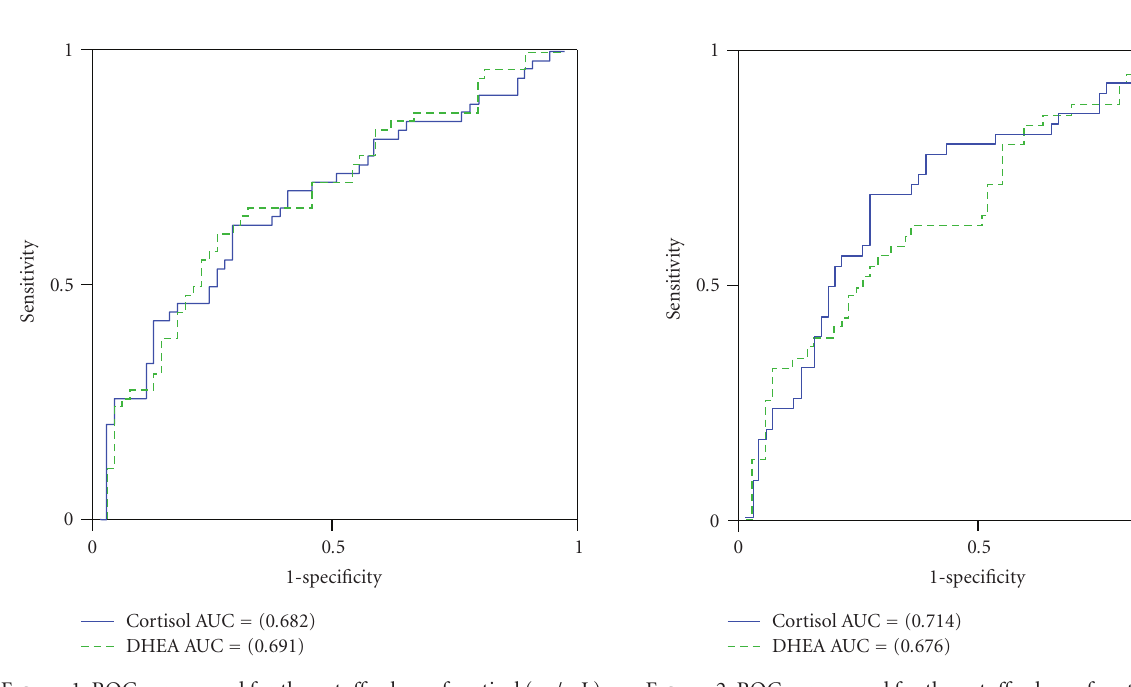
Figure 2: ROC curves used for the cuto ff values of cortisol (ng/mL) and DHEA (pg/mL) in saliva to screen CAL levels in